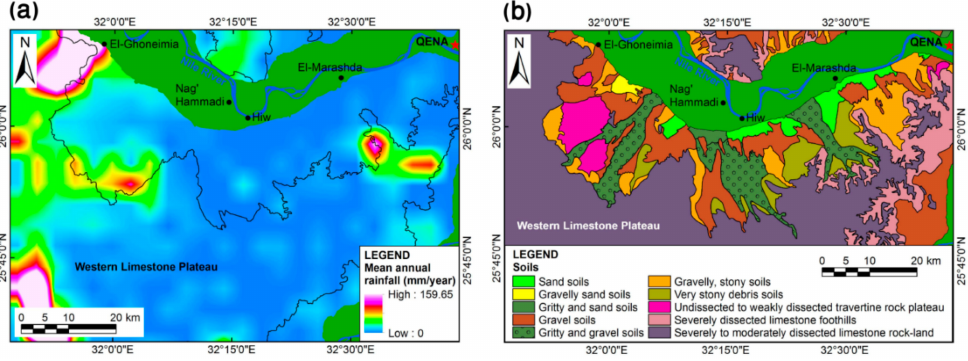
Figure 6. ( a ) TRMM rainfall in the period (1998–2009); ( b ) surface soils. The solid green color surrounding the River Nile represents the vegetation